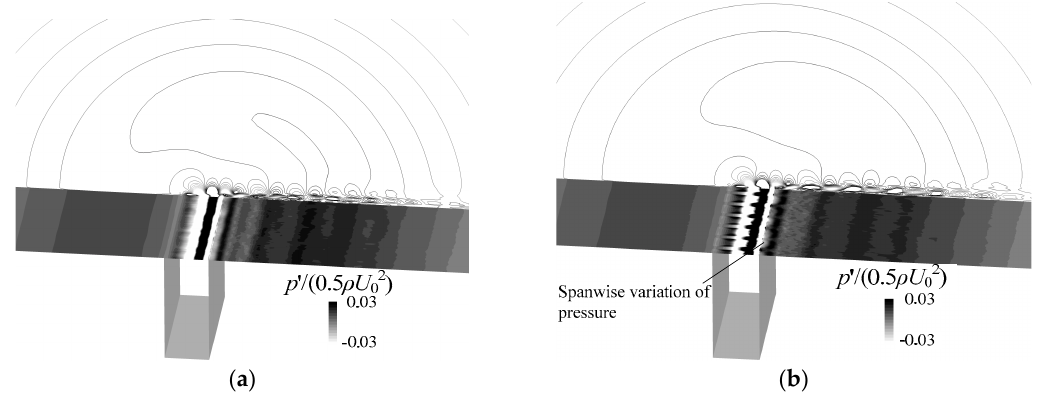
Figure 19. Contours of the fluctuation pressure at U 0 = 30 m/s for phase-averaged flow fields at the phase where the vortex collides with the downstream edge of the cavity: ( a ) baseline flow; and ( b ) controlled flow.